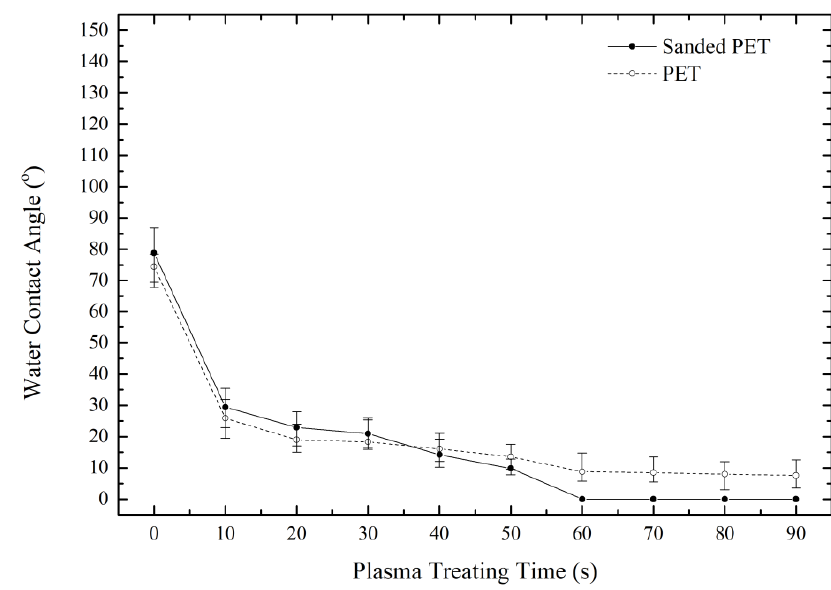
Figure 9. WCAs of PET films after various plasma treating times.